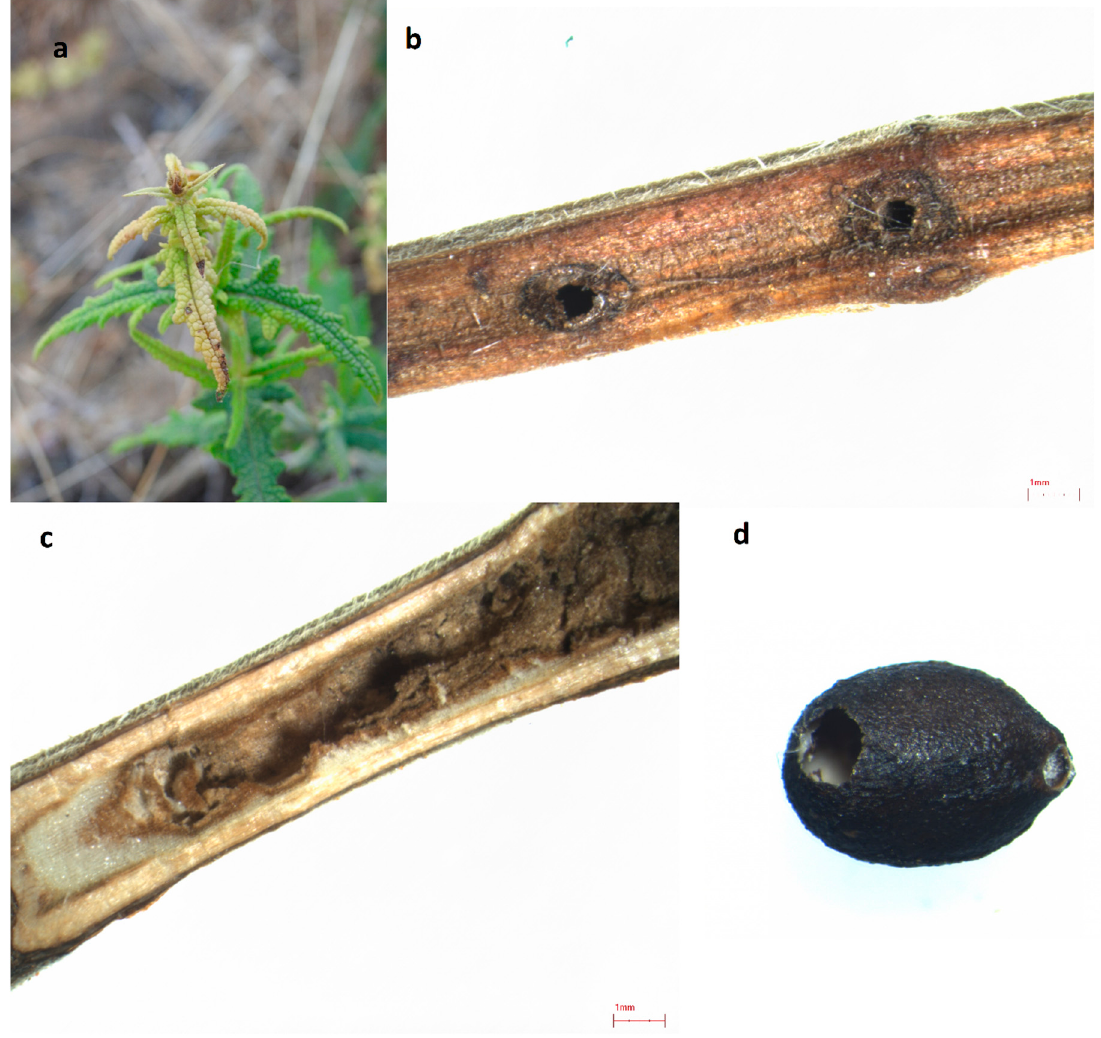
Figure 3. ( a ) S. ceratophylloides plants with a yellowed apex; ( b ) visible holes on the stem; ( c ) tunnels dug by Squamapion elongatum; ( d ) predated sage seed with an exit hole.